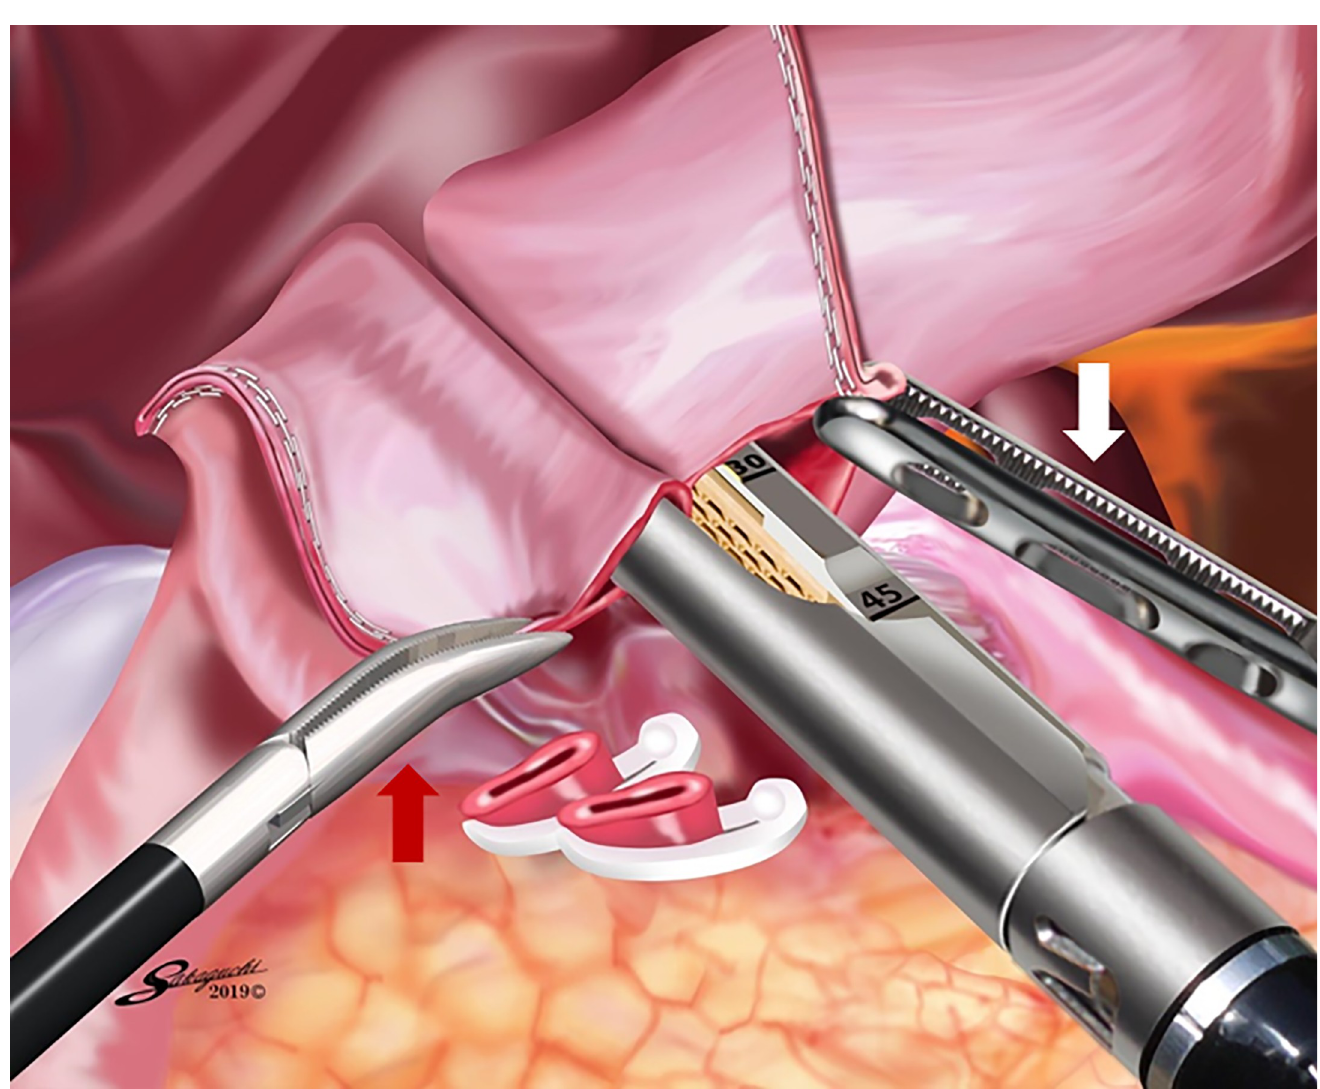
Fig 4. Linear stapling of the posterior walls of the remnant stomach and duodenum. Linear stapling of the posterior walls of the remnant stomach and duodenum without creating a gap using a 45-mm linear stapler with a staple length of 30 mm. The operator performs this stapling with the right hand while retracting the staple line of the duodenum laterally with the left hand (red arrow). The first assistant retracts the staple line of the remnant stomach laterally (white arrow).